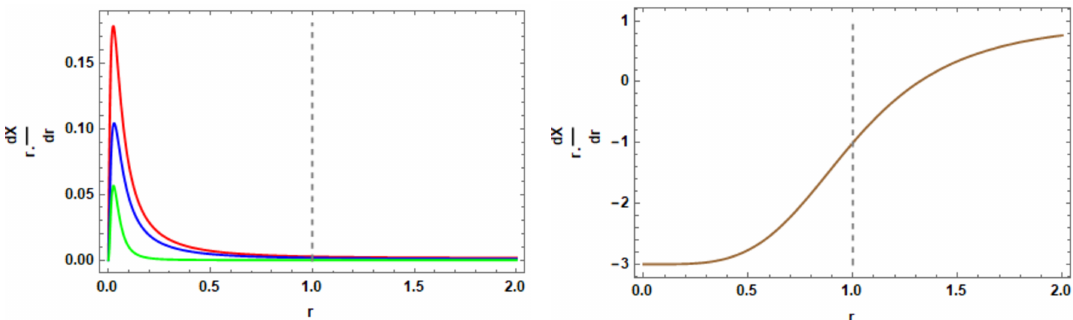
log 3 − 0 . 001 , φ 3 ( r h ) = 1 √ log 2 − 0 . 001 . 2 6 = 50 . 98 . For the left figure from top to bottom X are respectively T ( r ) . In the both figures dotted vertical line tt